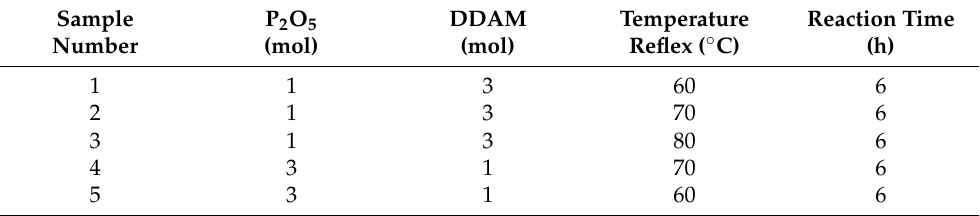
Table 1. Reaction conditions for the synthesis of rosin-based phosphorous